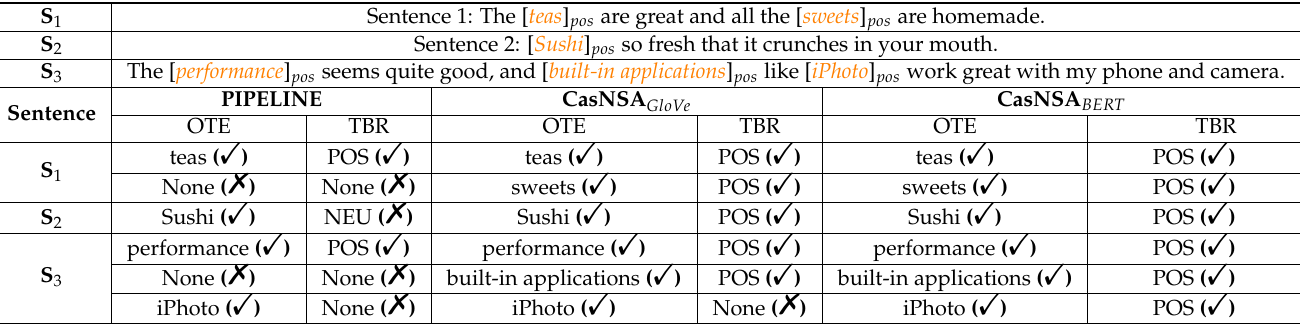
Table 5. Case analysis. The “OTE” column contains the results from the Target Boundary Recognizer (TBR) module for the sub-task of opinion-target extraction (OTE) and the “TSA” column contains the results from the Sentiment Polarity Identifier (SPI) module for the sub-task of target-oriented sentiment analysis (TSA). Words in red and italic are annotated aspect/opinion target terms with subscripts denoting their sentiment polarities. The marker ( (cid:37) ) denotes the incorrect prediction and ( (cid:33) ) denotes the correct prediction. We choose the RACL GloVe as the PIPELINE